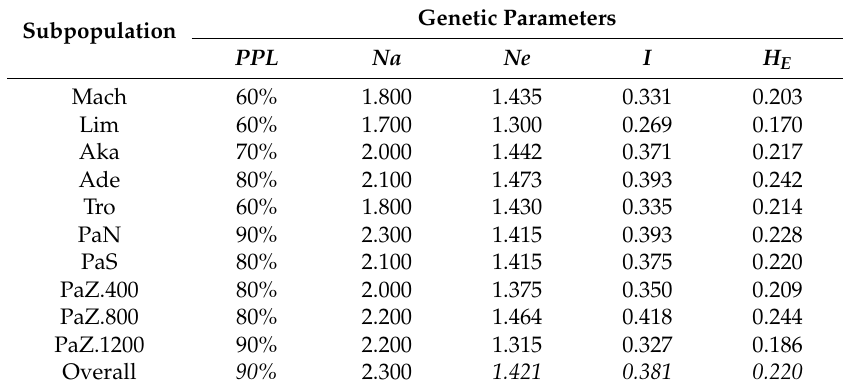
Table 2. Patterns of genetic variation at multilocus level over subpopulations in P. brutia in Cyprus. Genetic Parameters Subpopulation PPL Na Ne I H E Mach 60% 1.800 1.435 0.331